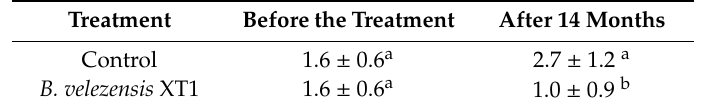
Table 1. Symptom Severity in the Palliative Treatment of Verticillium Wilt on Adult Diseased Trees with B. velezensis XT1.